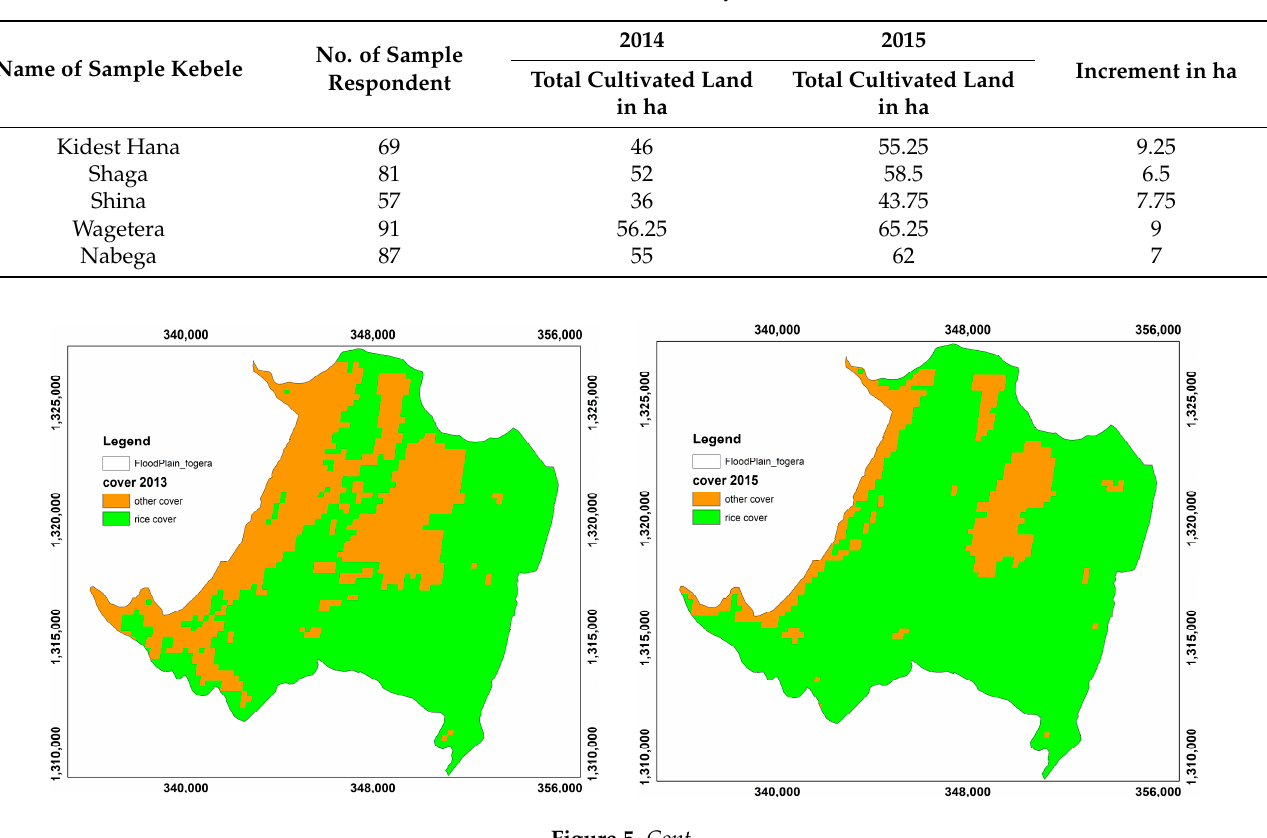
Table 2. Expansion of farmland for rice production.